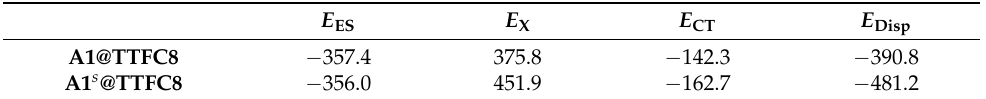
Table 3. Change in energetic contributions to the inter-component interaction in A1@TTFC8 and